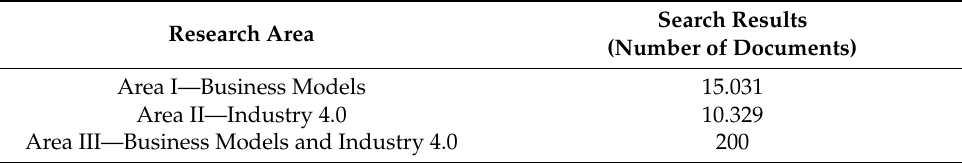
Figure 5. Growth dynamics of published articles in the WoS database from 1 January 2011 to 31 October 2021 in the field of business models and Industry 4.0. Source: own elaboration. Table 1. Search results for each area.